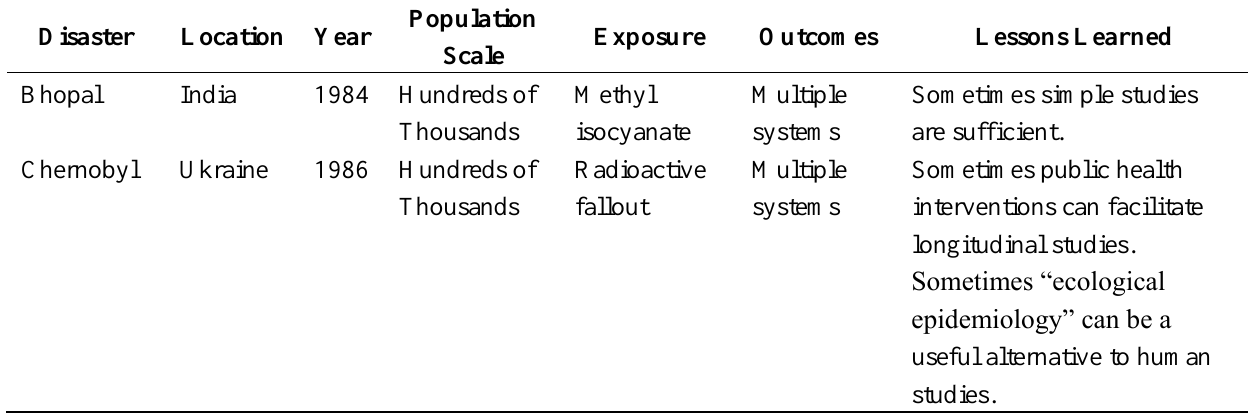
Table 1. Epidemiologic methods lessons learned from four Environmental Public Health Disasters.